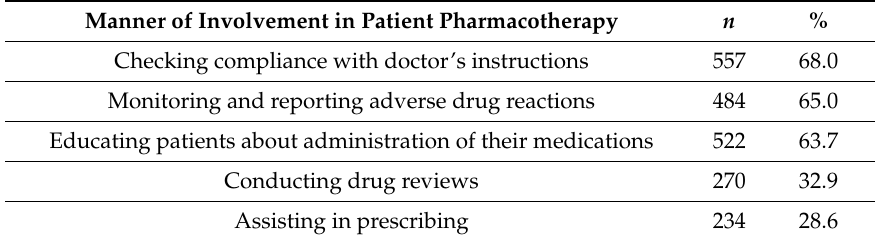
Table 2. Distribution of respondents’ answers to the question about the patient pharmacotherapy roles they fulfilled, n =